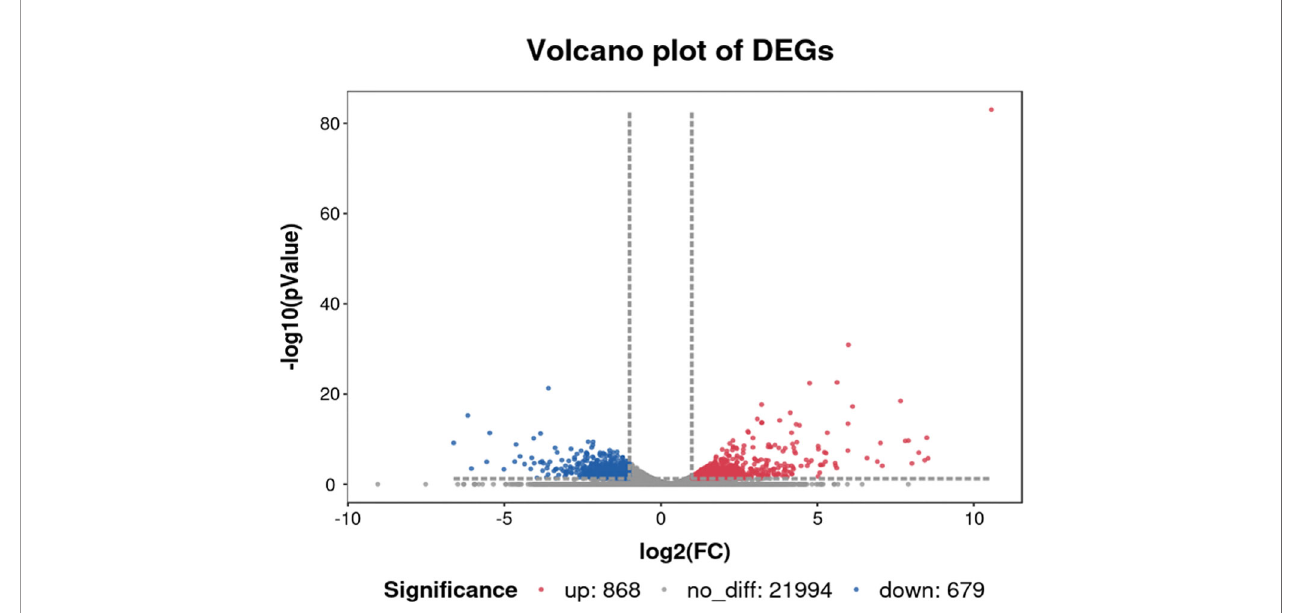
FIGURE 5 | Volcano plot of differentially expressed genes in yellow cat fi sh under transport stress vs. yellow cat fi sh in control group. Red and blue dots represent upregulated and downregulated DEGs in transport group compared with control group, respectively. Gray dots represent genes showing no signi fi cant differences in expression.